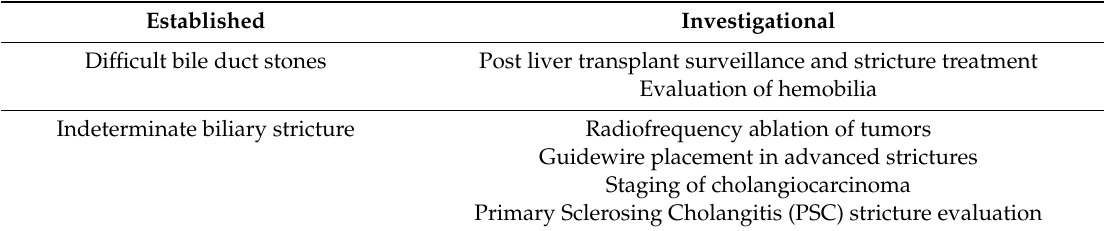
Table 3. Established and investigational uses of